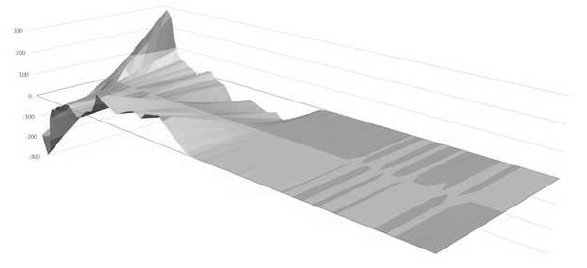
Figure 1: The transversal slope, which is calculated from the normal- ized flatness data of the